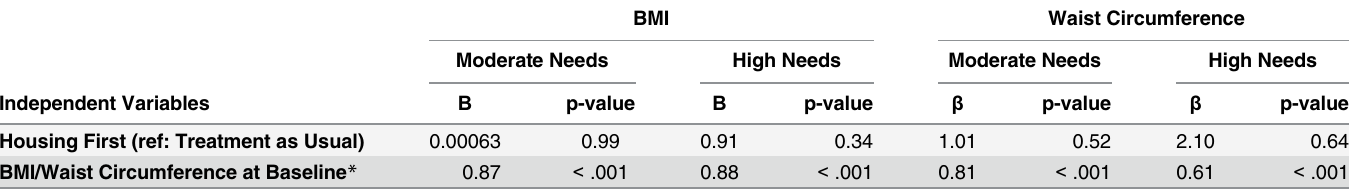
Table 3. ANCOVA Results for Changes in Body Mass Index (BMI) and Waist Circumference from Baseline to 24